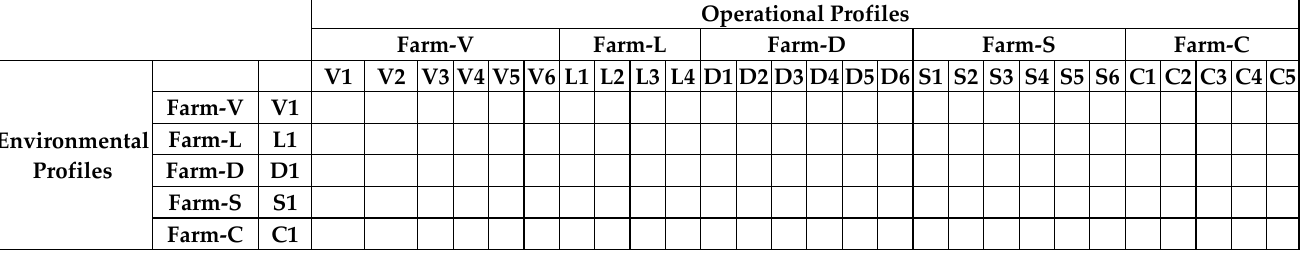
Table 1. Simulation Matrix (SM).